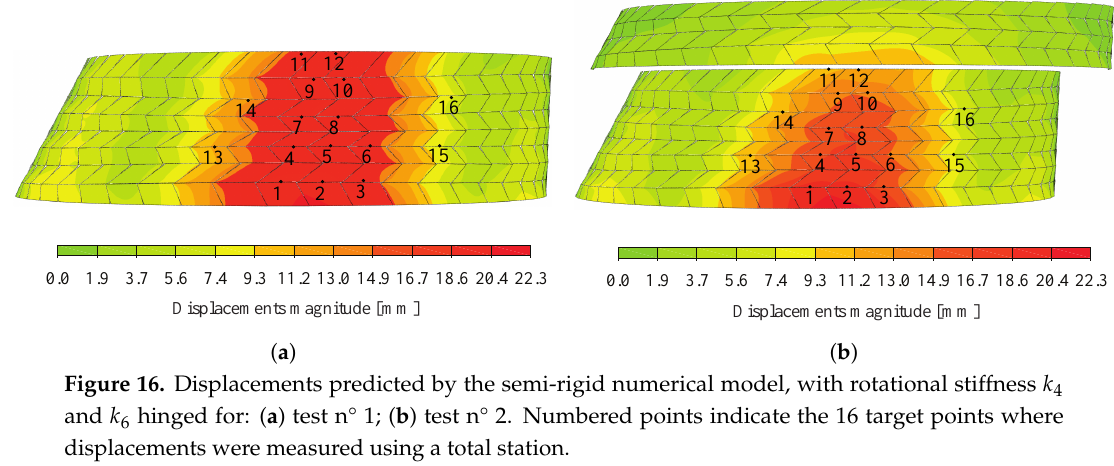
Figure 16. Displacements predicted by the semi-rigid numerical model, with rotational stiffness k 4 and k 6 hinged for: ( a ) test n° 1; ( b ) test n° 2. Numbered points indicate the 16 target points where displacements were measured using a total station.